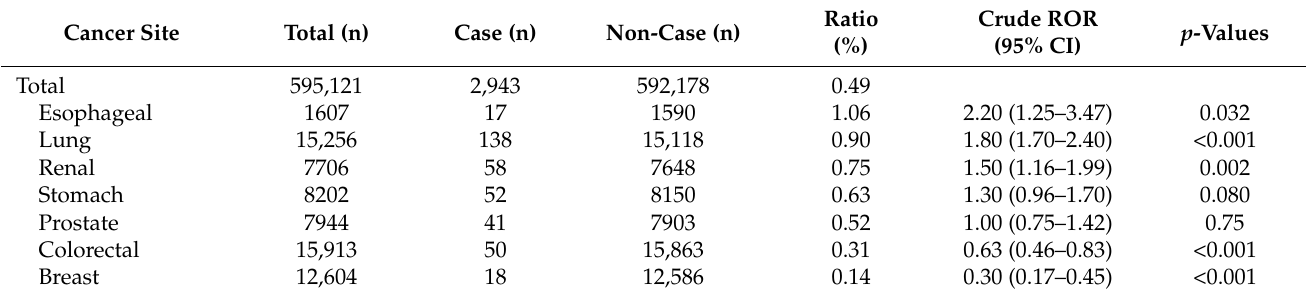
Table 2. The number of reported cases and crude ROR (95% CI) of hyponatremia according to the cancer